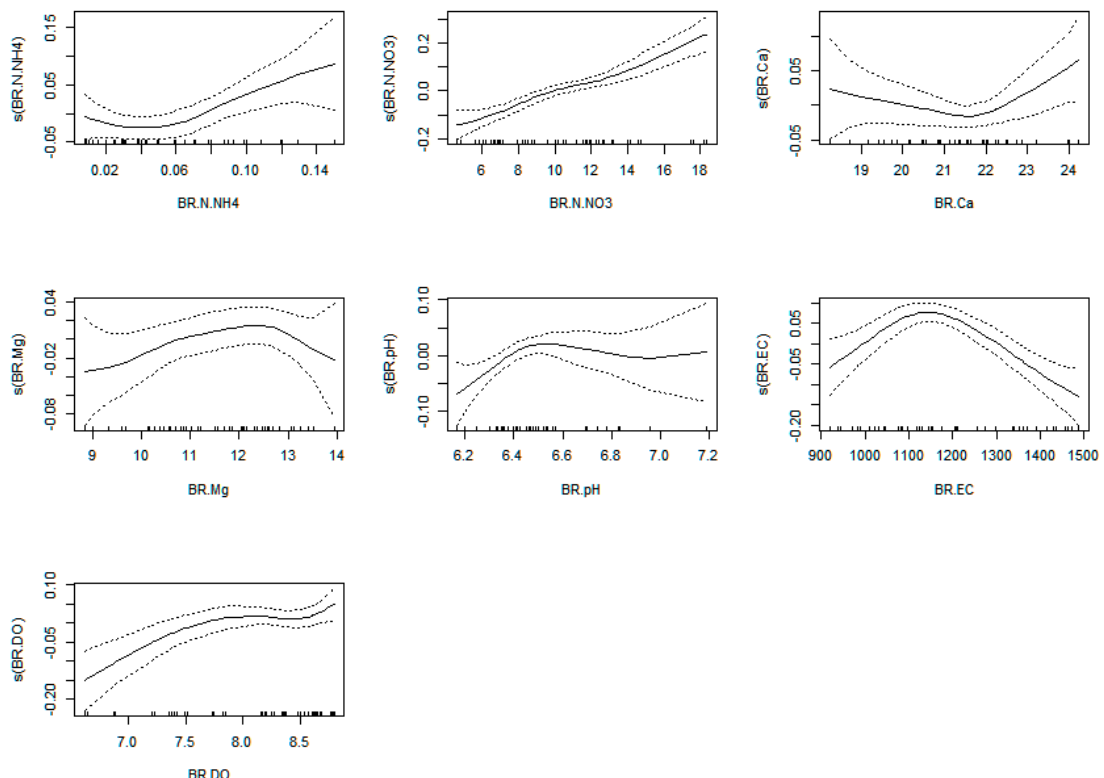
Figure A25. The GAM predictors influence over N-NO 2 for BR experimental variant.